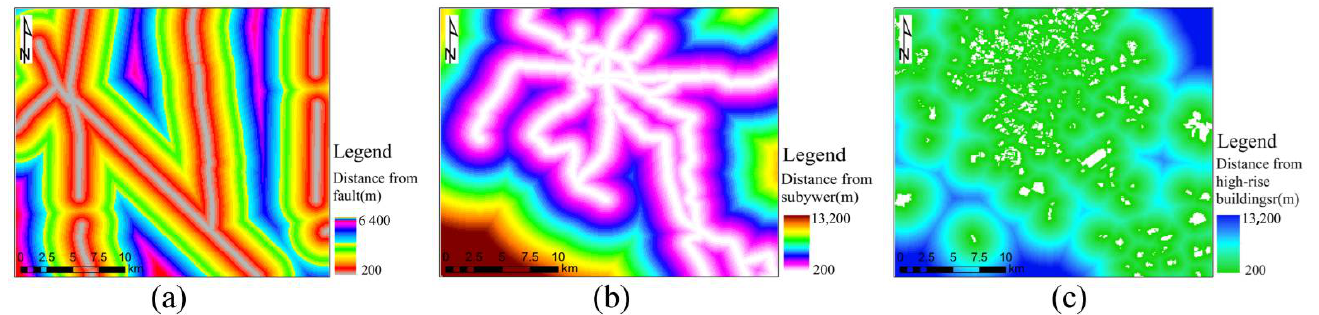
Figure 4. Quantitative processing of qualitative factors: ( a ) shows the distance to fault obtained by buffer analysis and erasure analysis; ( b ) shows the distance to fault obtained by buffer analysis and erasure analysis; ( c ) represents the distance to high-rise buildings obtained by buffer analysis and erasure analysis.